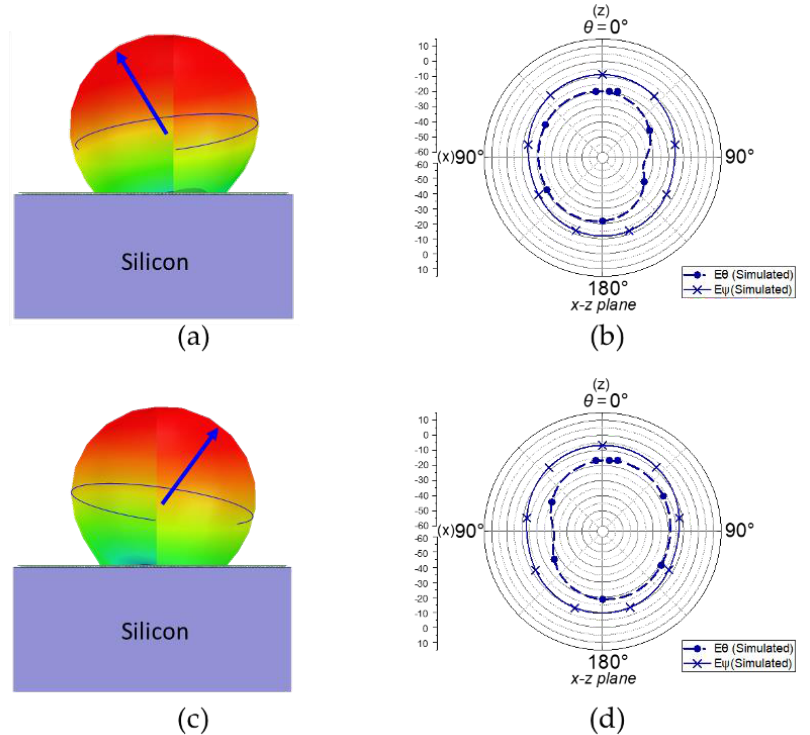
Figure 19. ( a ) 3D field pattern at port 1 feed, ( b ) x - z plane field pattern at port 1 feed, ( c ) 3D field pattern at port 3 feed, and ( d ) x - z plane field pattern at port 3 feed.